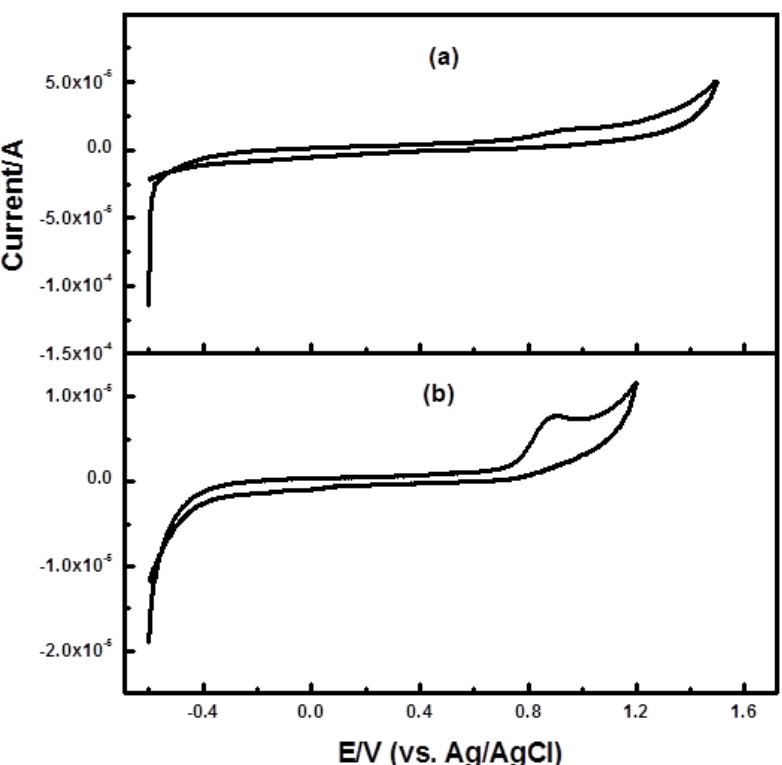
Figure 8. Electrochemical behavior of 1 × 10 − 3 M ( a ) parathion and ( b ) fenitrothion in a phosphate buffer (pH = 8.0) using cyclic voltammetry.